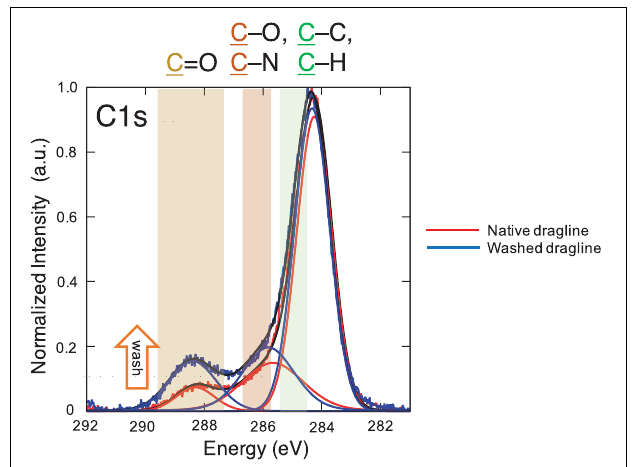
FIGURE 4 | XPS spectra of the native spider dragline (red) and spider dragline after washing with ether (blue). The peak fitting results are also shown in the same color. The details on the peak fitting is described in Experimental section.